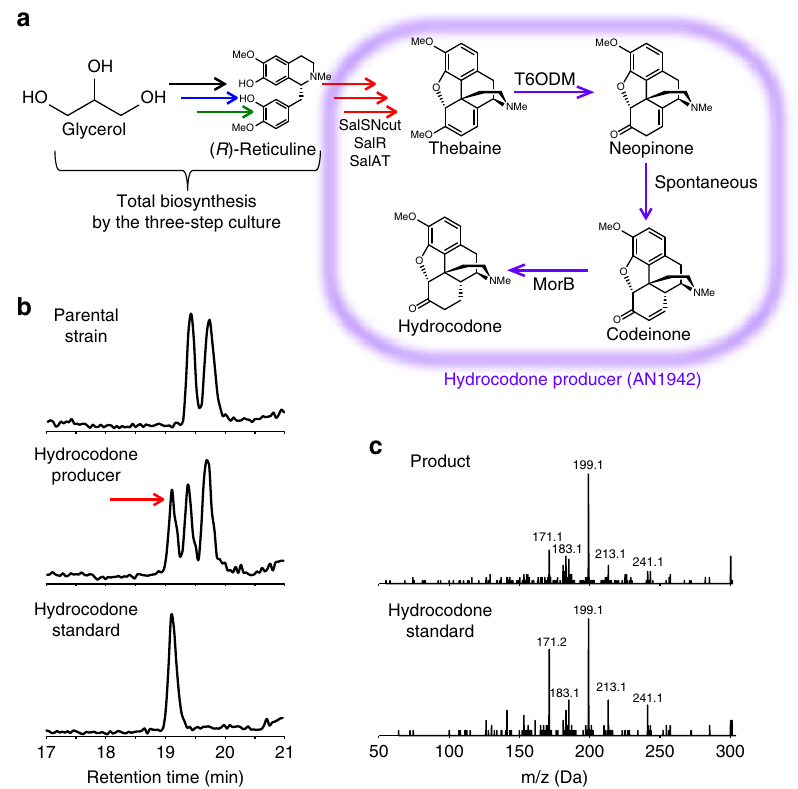
Figure 4 | Total biosynthesis of hydrocodone. ( a ) Schematic representation of the total biosynthesis of hydrocodone. ( b ) LC-MS analysis of hydrocodone ( m / z ¼ 300) from the culture of the parental strain (thebaine producer, AN1829; upper panel), hydrocodone producer (AN1942; mid panel) and the peak standard of hydrocodone (lower panel). The peak indicated by the arrow was analysed for its MS/MS fragment pattern. ( c ) MS/MS fragment pattern of the products of AN1942 (upper panel) and the peak standard of hydrocodone (lower panel). Experiments in b , c were conducted three times, and same tendency was